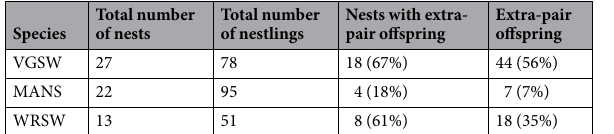
Table 1. Newly measured extra-pair paternity rates for three species of Tachycineta swallows. VGSW = Violet- green swallow, MANS = Mangrove swallow, WRSW = White-rumped